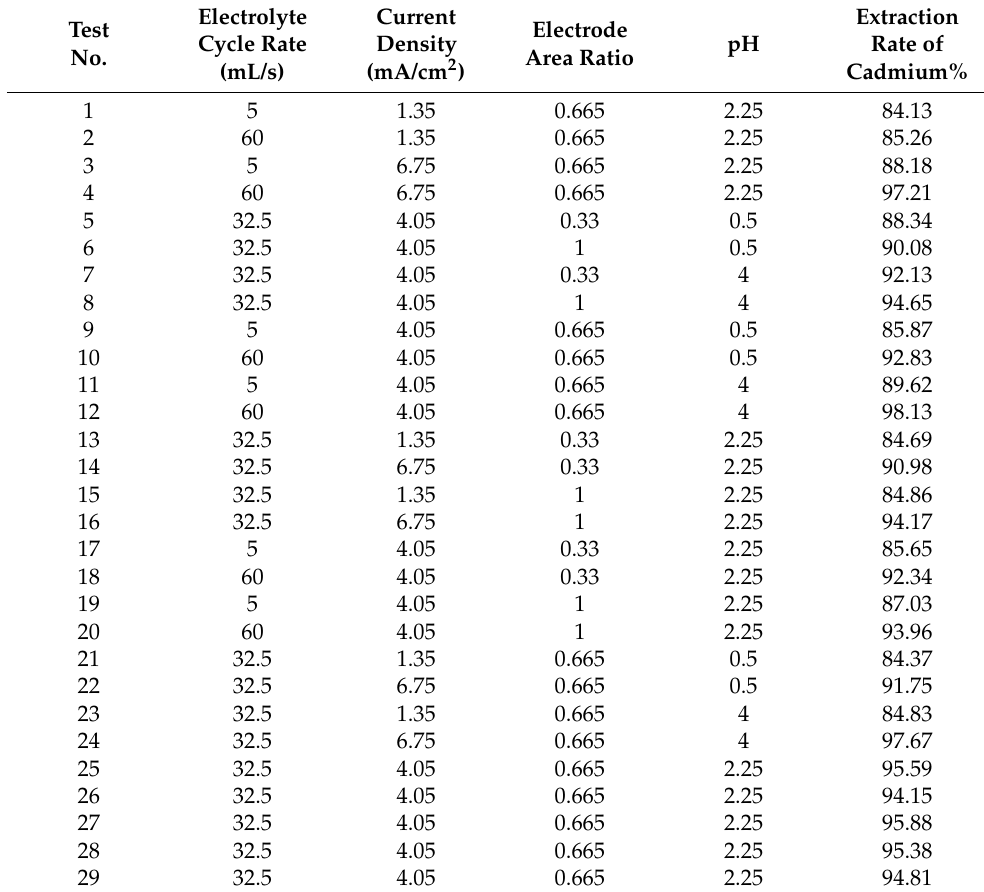
Table 4. The response surface experimental design and result.